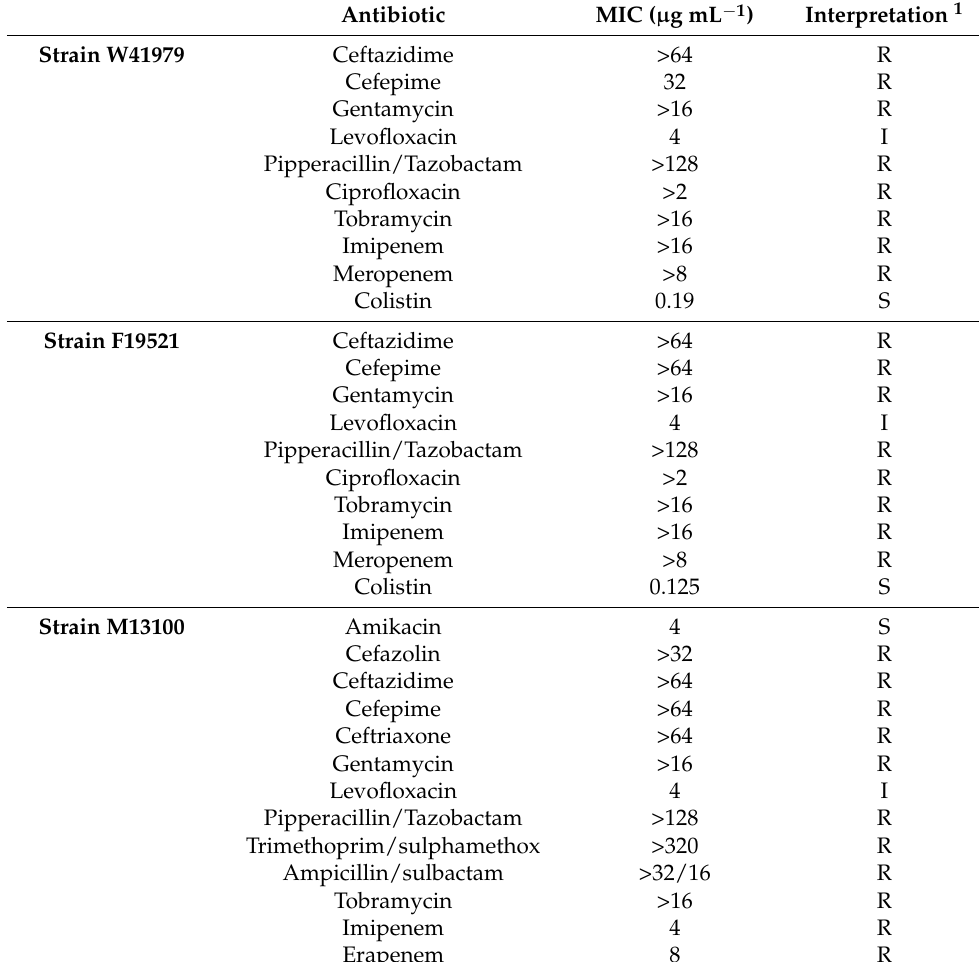
Table 1. Antibiotic susceptibility testing of A. baumannii